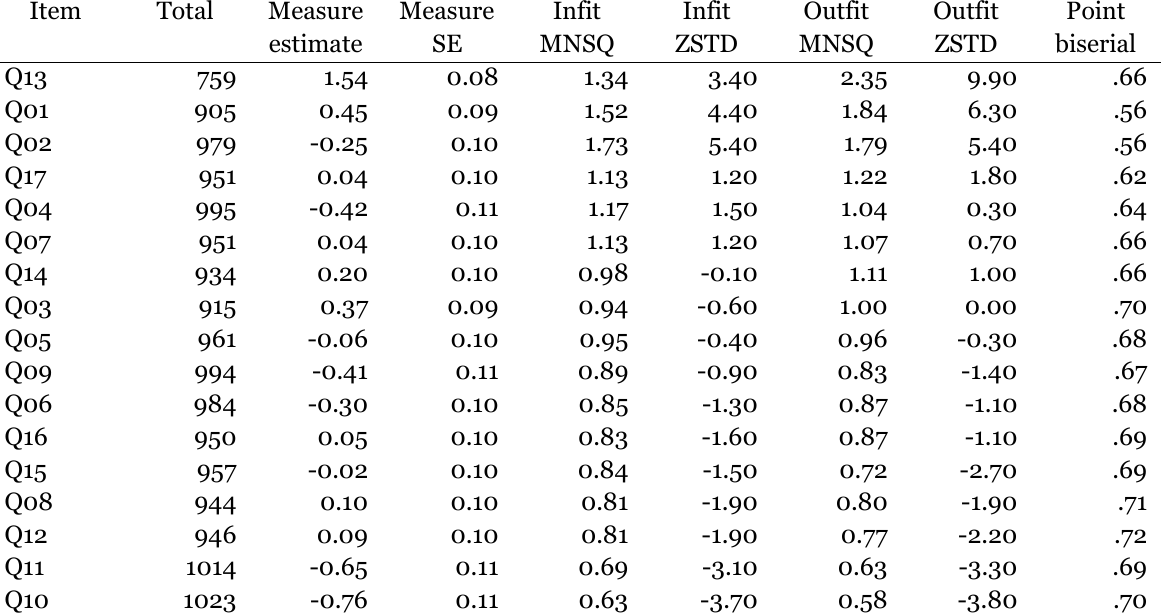
Table 4 Item Quality